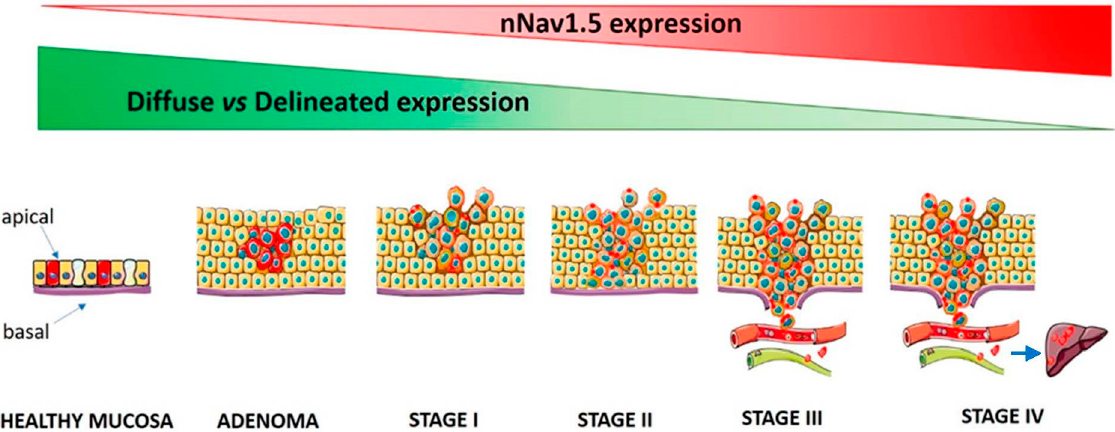
Figure 3. A schematic model illustrating how nNav1.5 expression changes during CRCa progression. Red and green wedges indicate, respectively, increasing expression of functional nNav1.5 protein and decreasing diffuseness/increased delineation of its cellular distribution. Lymphatic vessels are depicted in green while blood vessels are in red. For TNM IV, metastasis to liver is common.